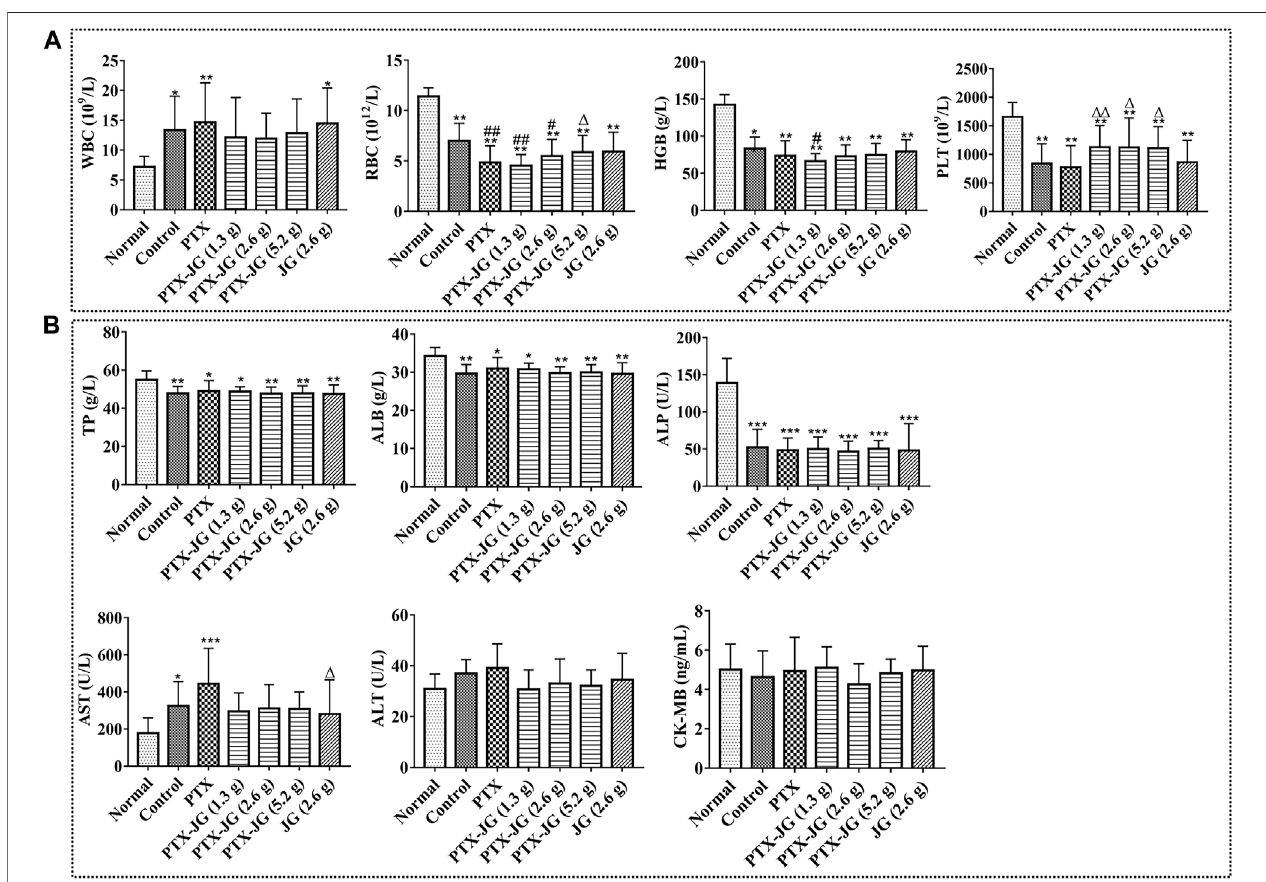
FIGURE 4 | Biochemical indices after the combination of JG with PTX in the Lewis lung cancer mice. (A) : Routine peripheral blood (WBC, RBCs, HGB and PLTs) were detected by assay kit (n = 12). (B) : TP, ALB, ALP, ALT, AST and CK-MB levels were detected by assay kit (n = 10). * p < 0.05, ** p < 0.01, *** p < 0.001, vs Normal group; # p < 0.05, ## p < 0.01, vs Control group. △ p < 0.05, △△ p < 0.01, vs PTX